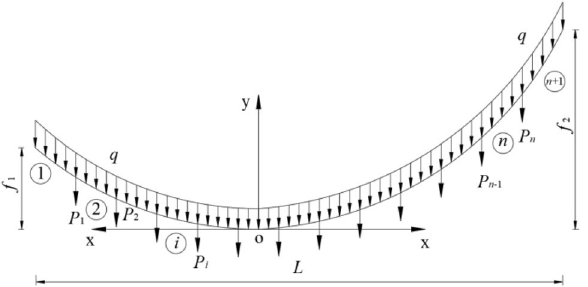
Figure 1. Schematic diagram of the main cable shape calculation model and cable segment division in coordinate system